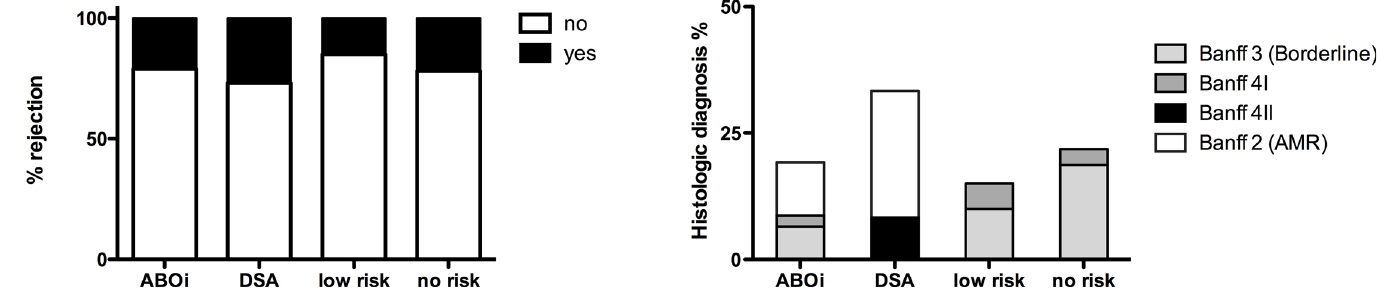
PLOS ONE | DOI:10.1371/journal.pone.0146075 January 5,